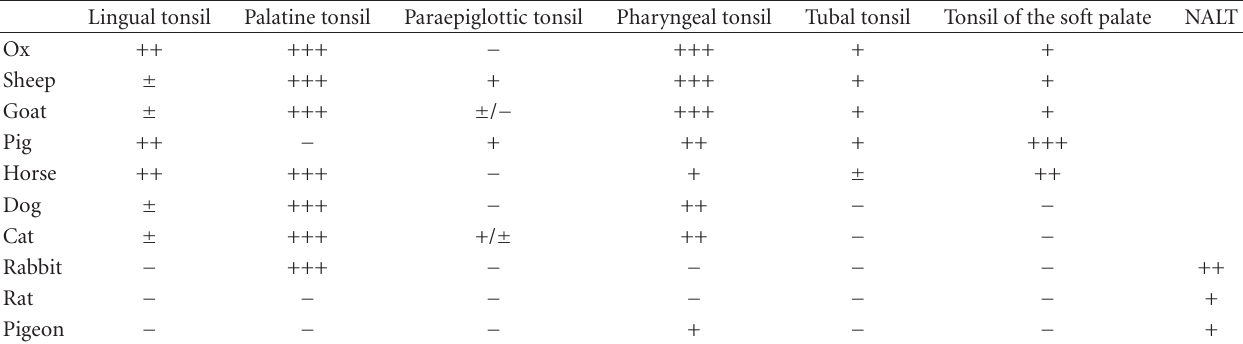
Table 1: Presence and relative volume of the tonsils and lymphoid tissues in various domestic animals. Lingual